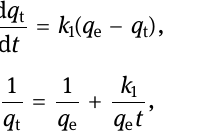
Figure 8: E ff ect of contact time on the adsorption e ffi ciency of Cd 2 +